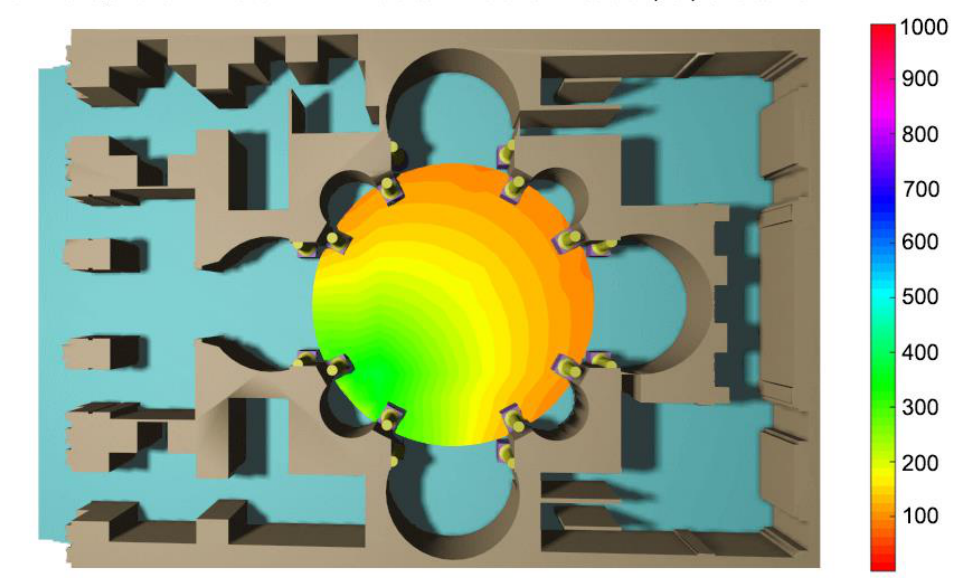
Figure 4. Simulations for the typical spring sunny day values in lux. This case occurs in 74% of the total time (76% during harvest). The distribution is reversed in the south–north axis at 8.45 h. Source: Authors.